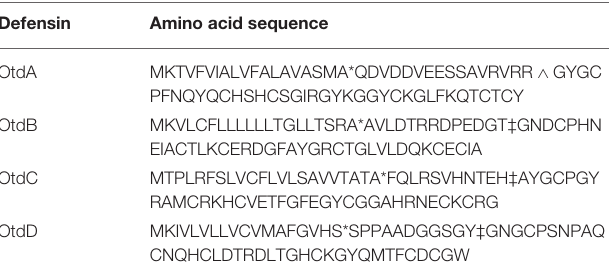
TABLE 2 | Predicted cleavage sites of putative O. turicata